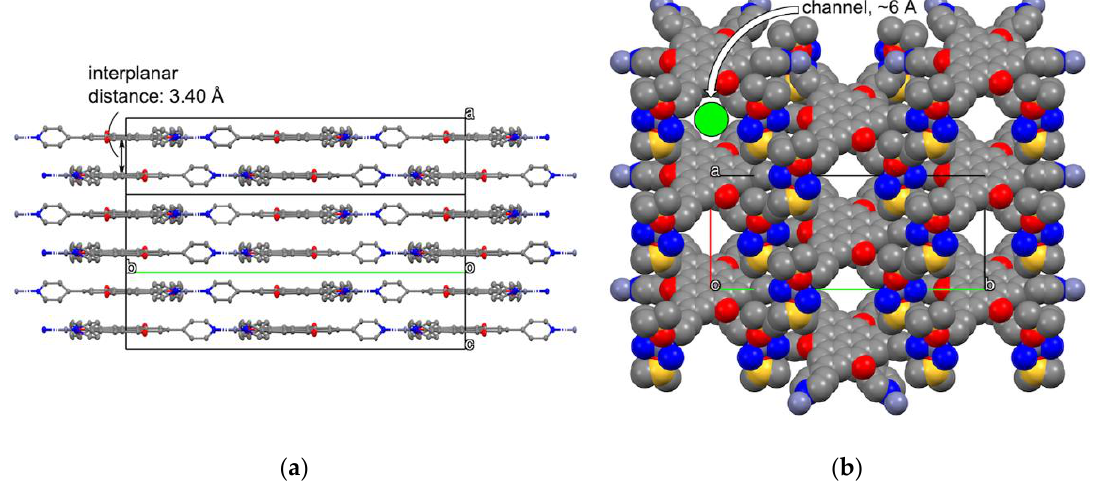
Figure 5. Crystal packing of 5 . ( a ) Side view of the 2D coordination sheet showing the π -stacking motif of TOT monoanion; ( b ) Crystal packing viewed along the c -axis in the space filling model. Green circle shows the 1D channel filled with NO 3 − and solvent molecules. Hydrogen atoms, disordered NO 3 − and solvent molecules are omitted for clarity. Color code: carbon (gray), nitrogen (blue), oxygen (red), sulfur (yellow), zinc (blue gray).